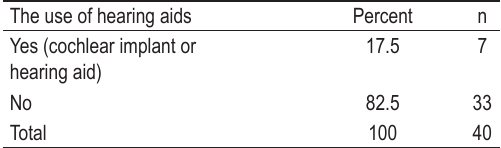
TABLE 6. Marital status